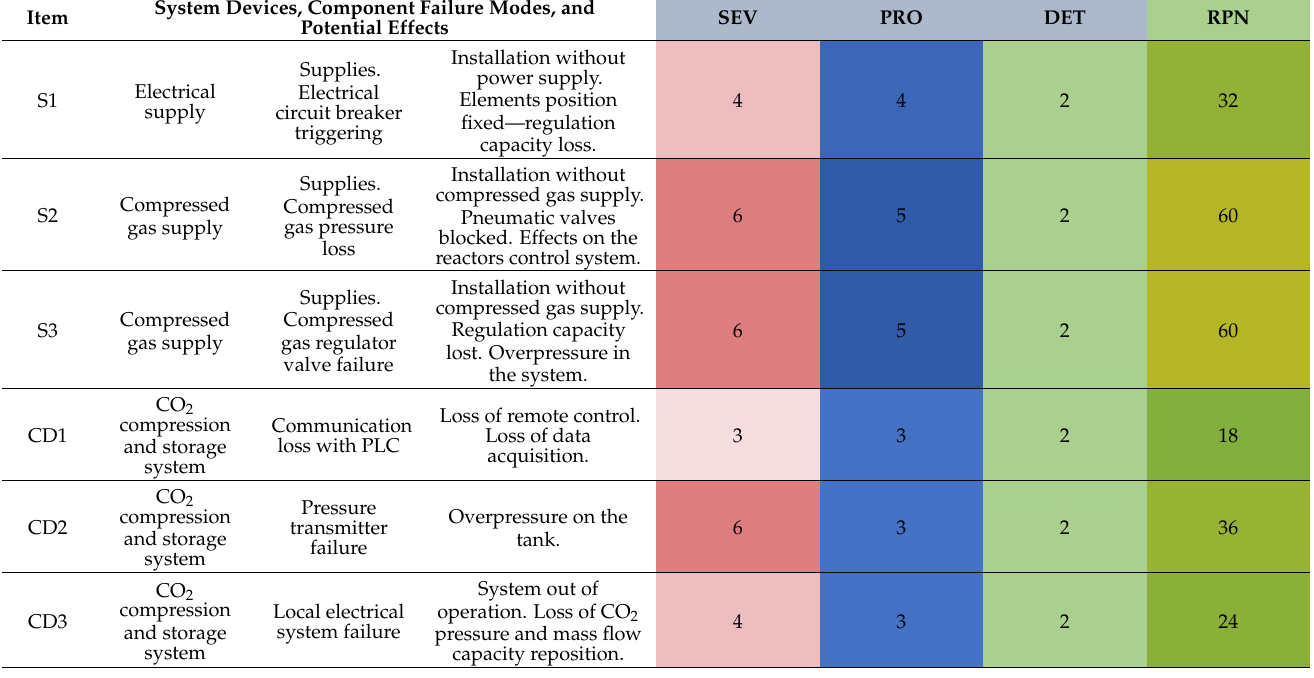
Table 5. Data collection and risk assessment of the FMEA analysis of the supplies and CO 2 compression system. System Devices, Component Failure Modes, and Potential